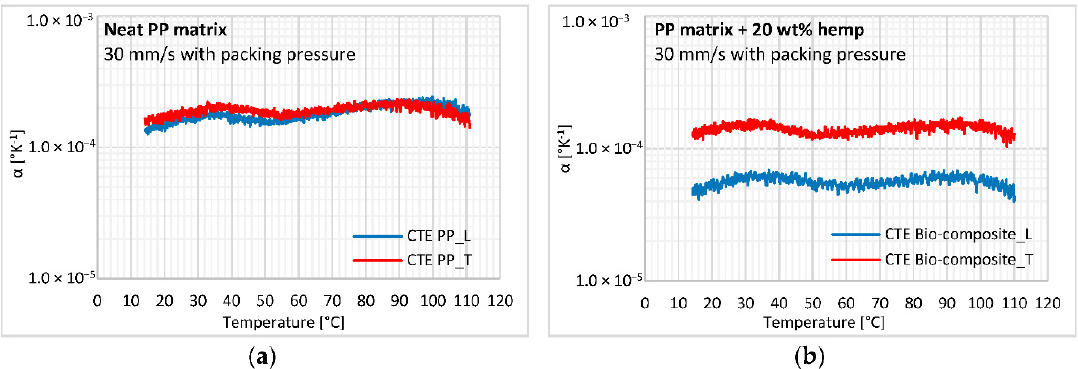
Figure 15. Changes in longitudinal and transverse coefficient of thermal expansion (CTE) during cooling for the ( a ) neat PP matrix and ( b ) PP reinforced with hemp fibers.